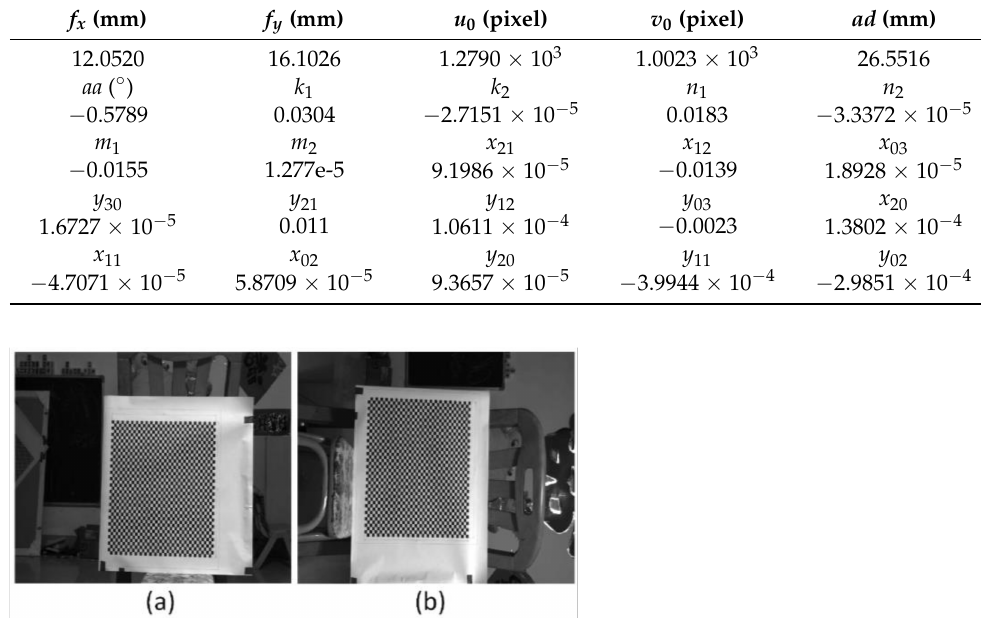
Figure 10. Anamorphic images. ( a ) Image when the anamorphic lens was in the vertical position, and ( b ) image when the anamorphic lens was in the horizontal position.